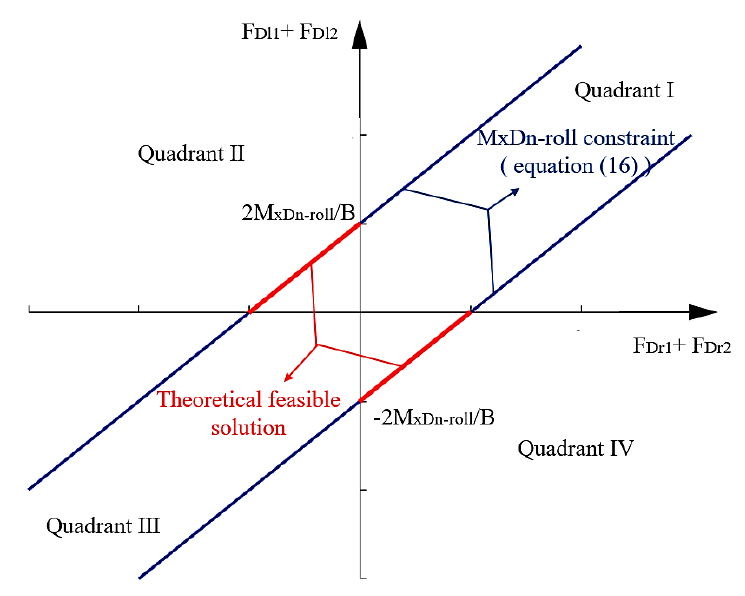
Figure 5. Feasible region of optimal distribution of damping force.